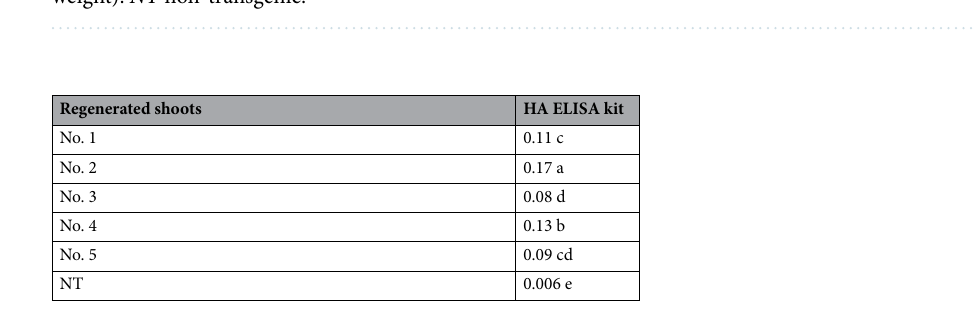
Table 3. Different levels of rhHAS2 were measured in all regenerated shoot lines. Quantities are in ng/kg (wet weight). NT non-transgenic.